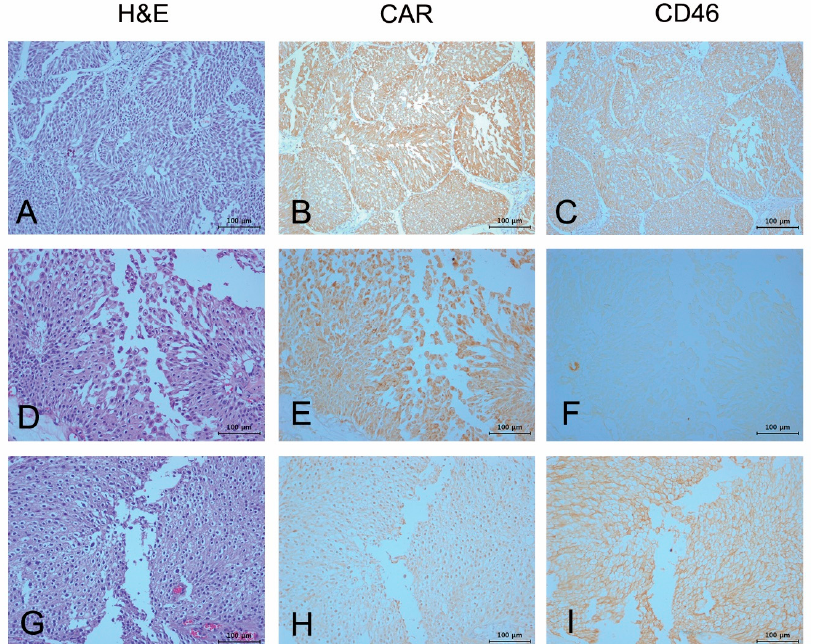
Figure 1. Immunohistochemical analysis of CD46 expression in bladder cancer patient samples. Serial sections of the selected bladder cancer tissues were immunostained with either antibodies to coxsackie ‐ adenoviral receptor (CAR) ( B , E , H ) or CD46 ( C , F , I ). While some tumors express both CAR and CD46 ( A – C ), others express either CAR ( D – F ) or CD46 ( G – I ) only. The scale bar represents 100 µ m. file attached. Table 1. Correlation between CD46 expression and clinico ‐ pathological features in patients with bladder cancer.